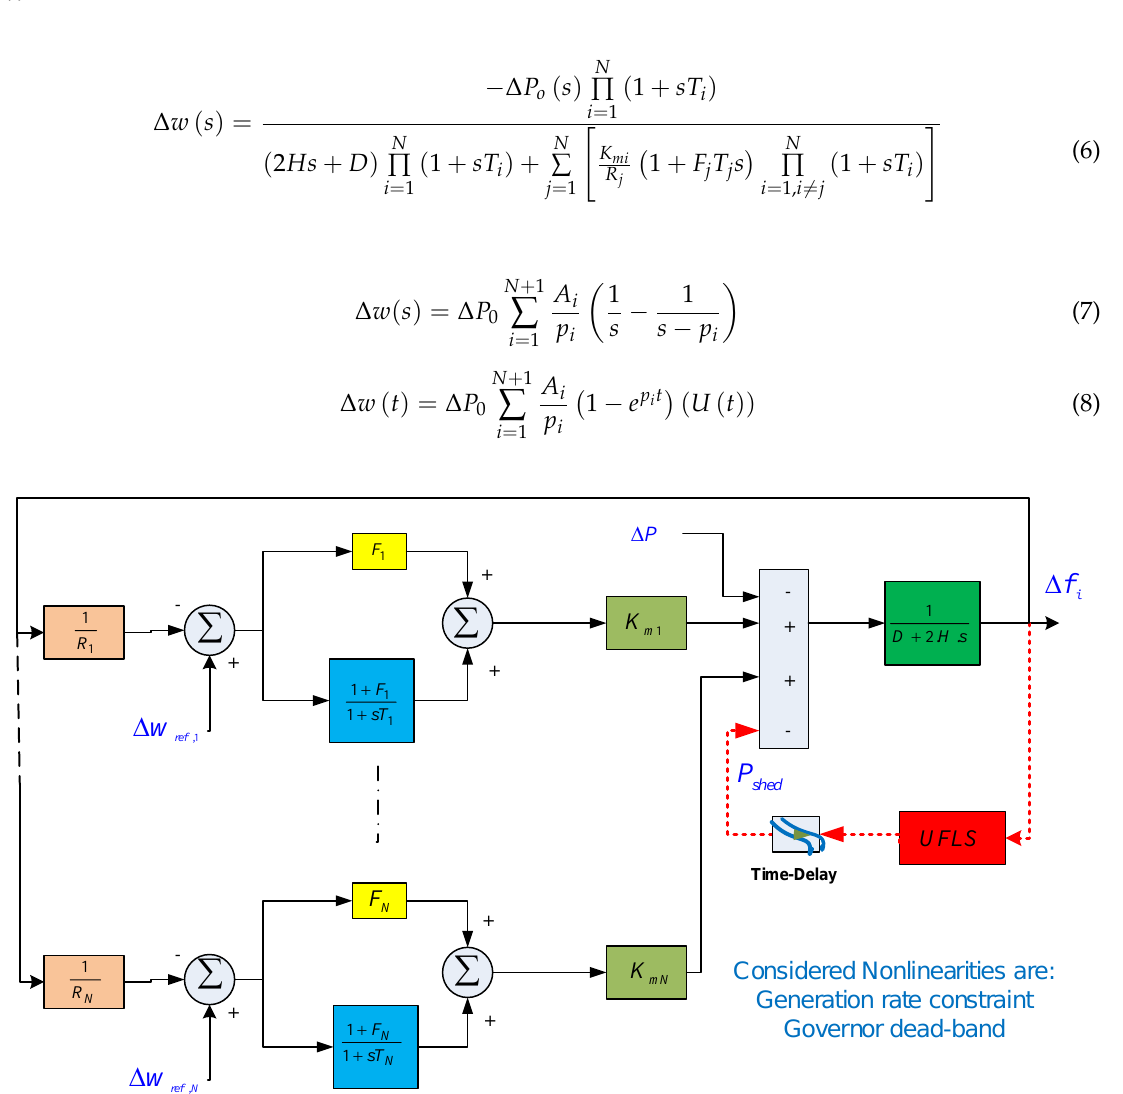
Figure 1. the general layout of the system frequency response (SFR)